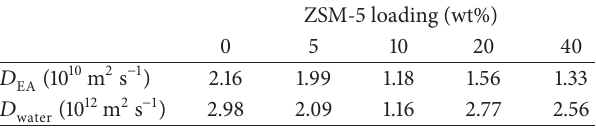
Table1:DiffusioncoefficientsofEAandwaterthroughPEBA/ZSM- 5 membranes with different ZSM-5 loading.